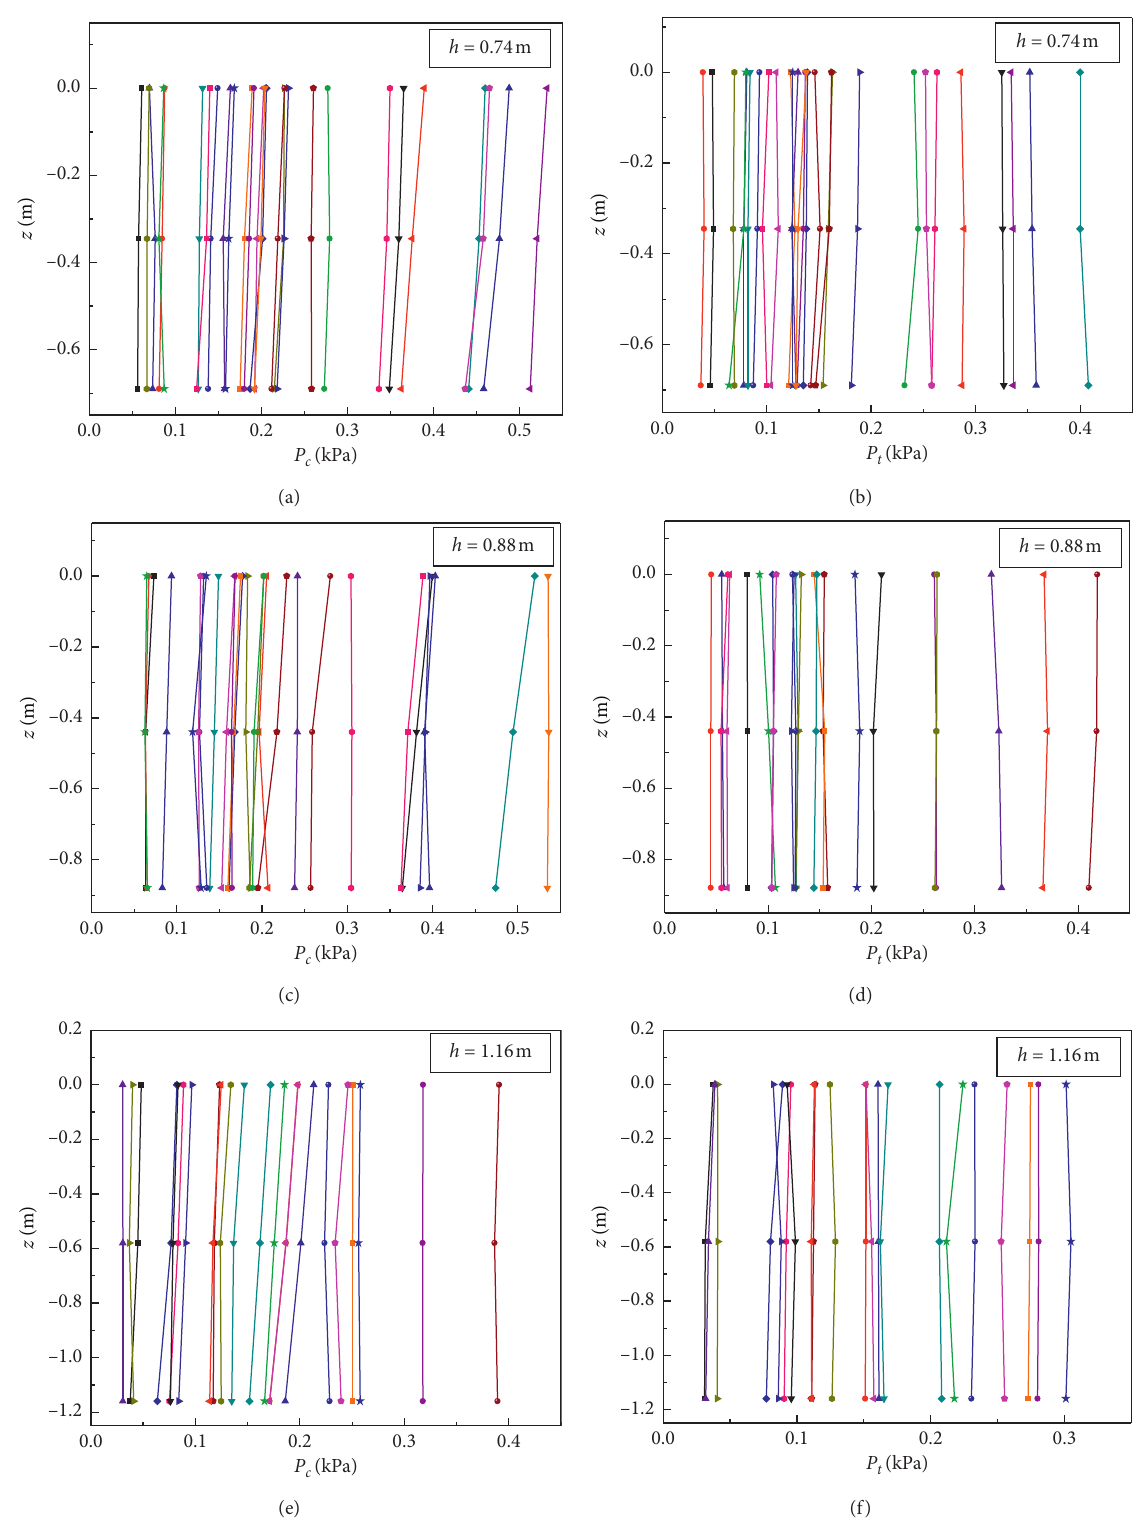
Figure 9: The distribution of wave pressure along water